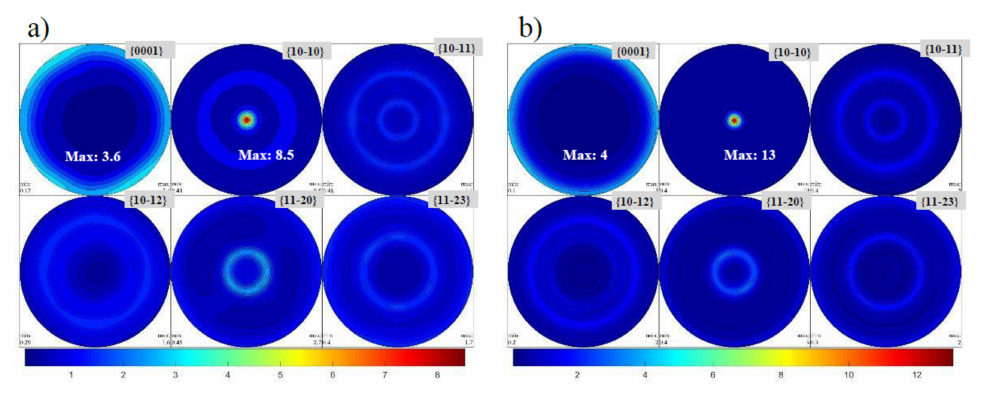
Figure 6. Basal, prismatic, and pyramidal pole figures of extruded ( a ) M10S µ and ( b ) M10S n